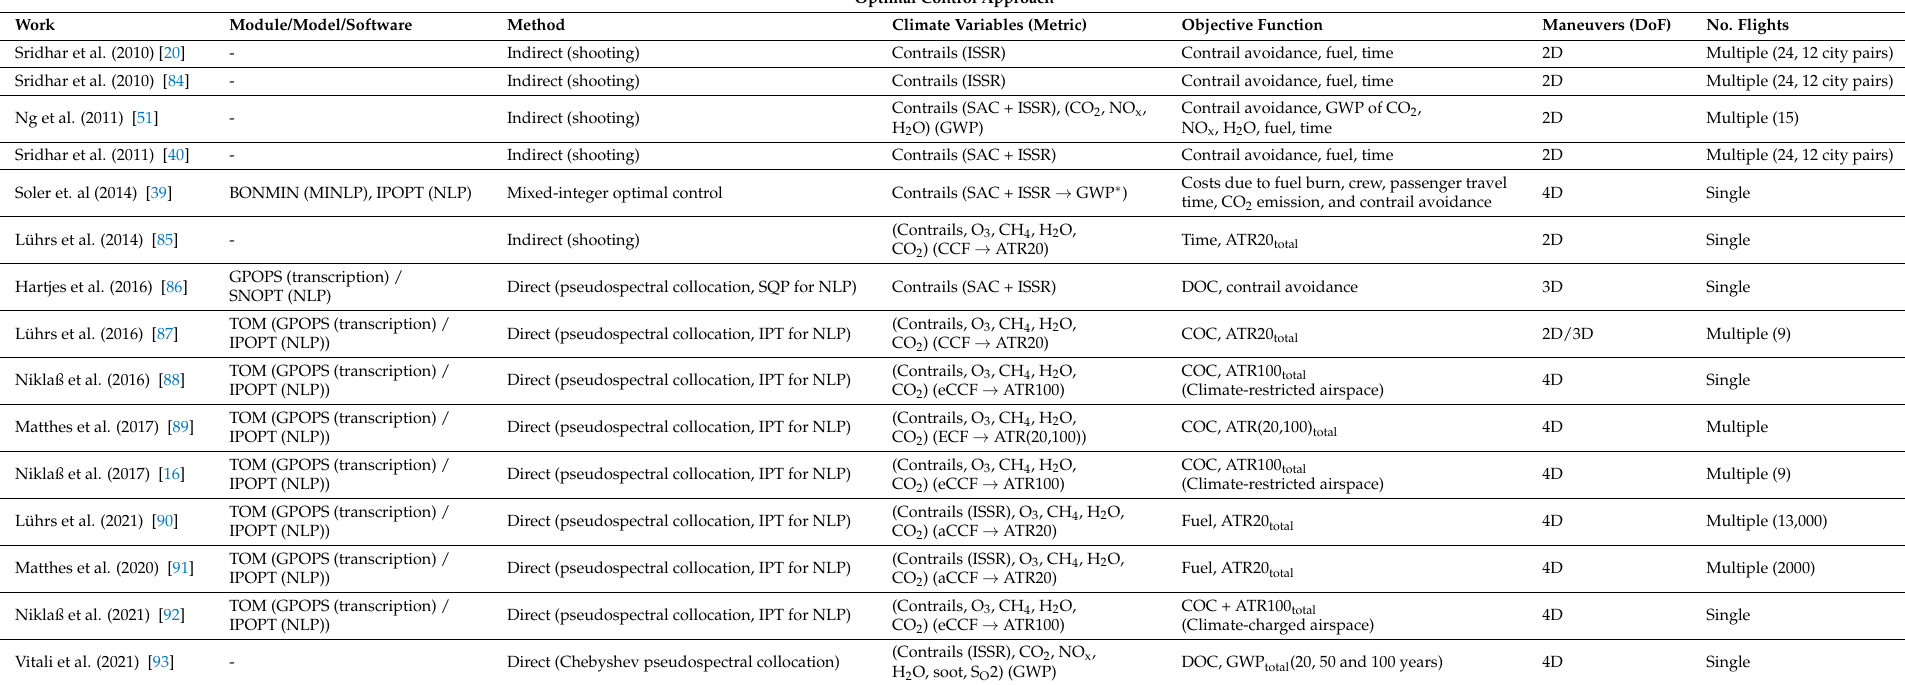
Table 3. Optimal control strategies proposed in the literature for climate optimal